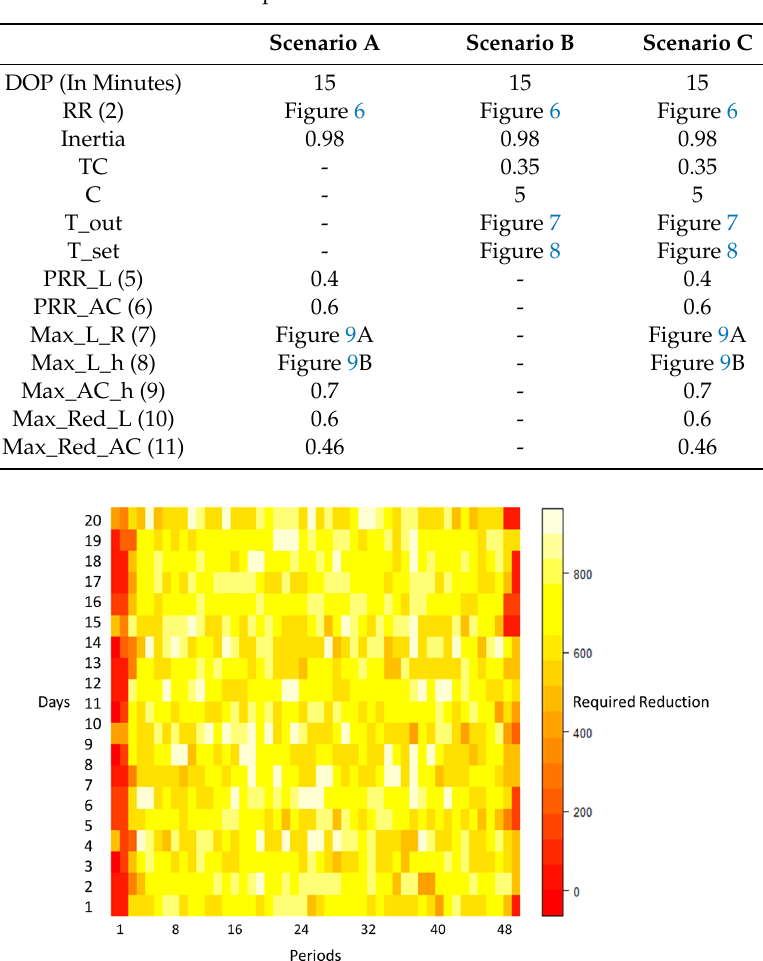
Table 2. The parameter values for each scenario.